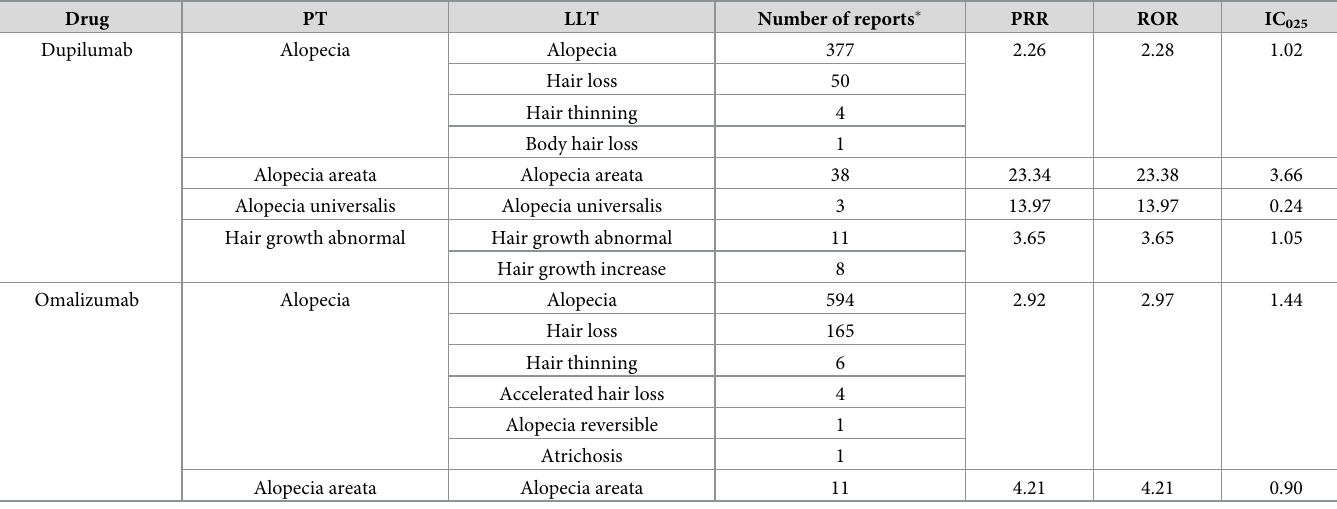
Table 4. Disproportionality analysis results of signals.